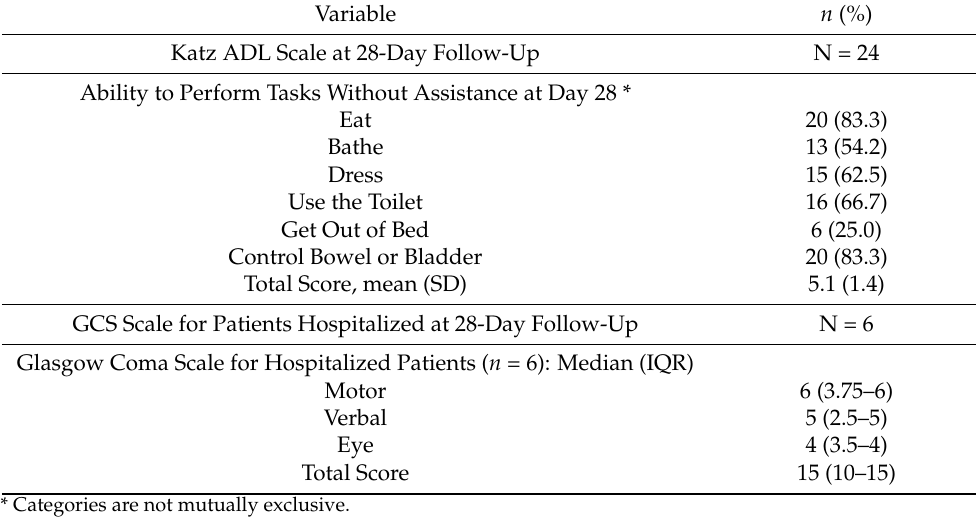
Table 2. Assessment of disability at baseline and at 28 days post-injury using Katz Activities of Daily Living Scale, and GCS for hospitalized patients.